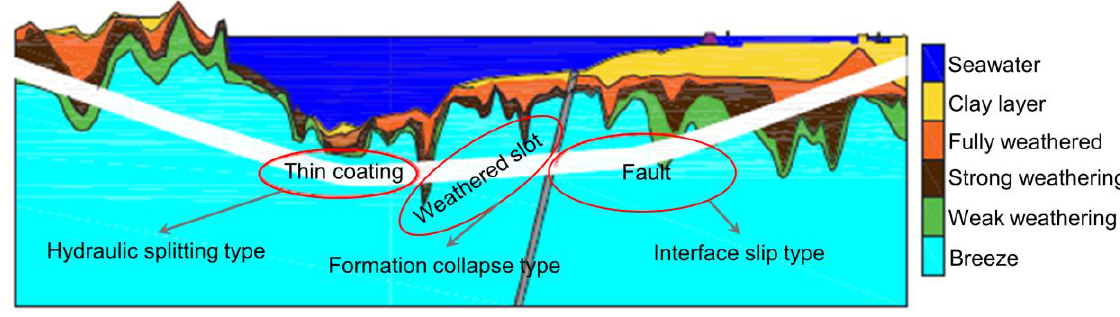
Figure 11. Water inrush modes [67].